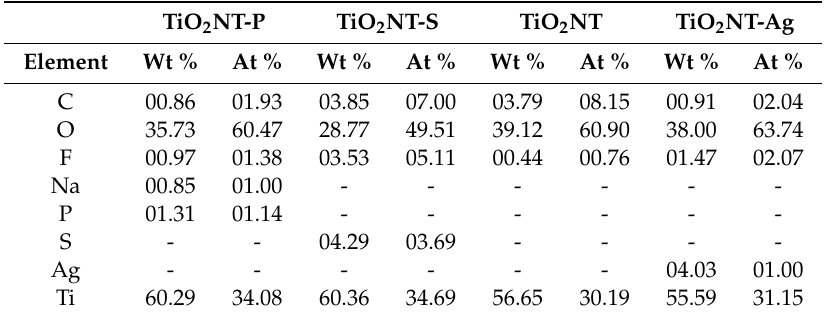
Table 2. Approximate surface elemental composition of the four di ff erent nanomaterials. TiO 2